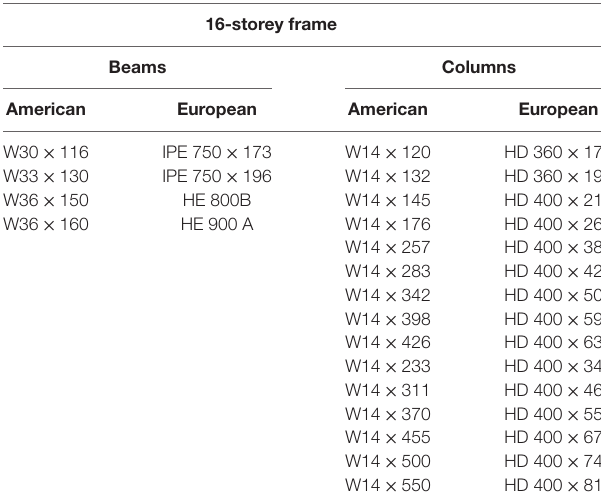
TaBle 4 | Selection of equivalent European sections for 16-storey